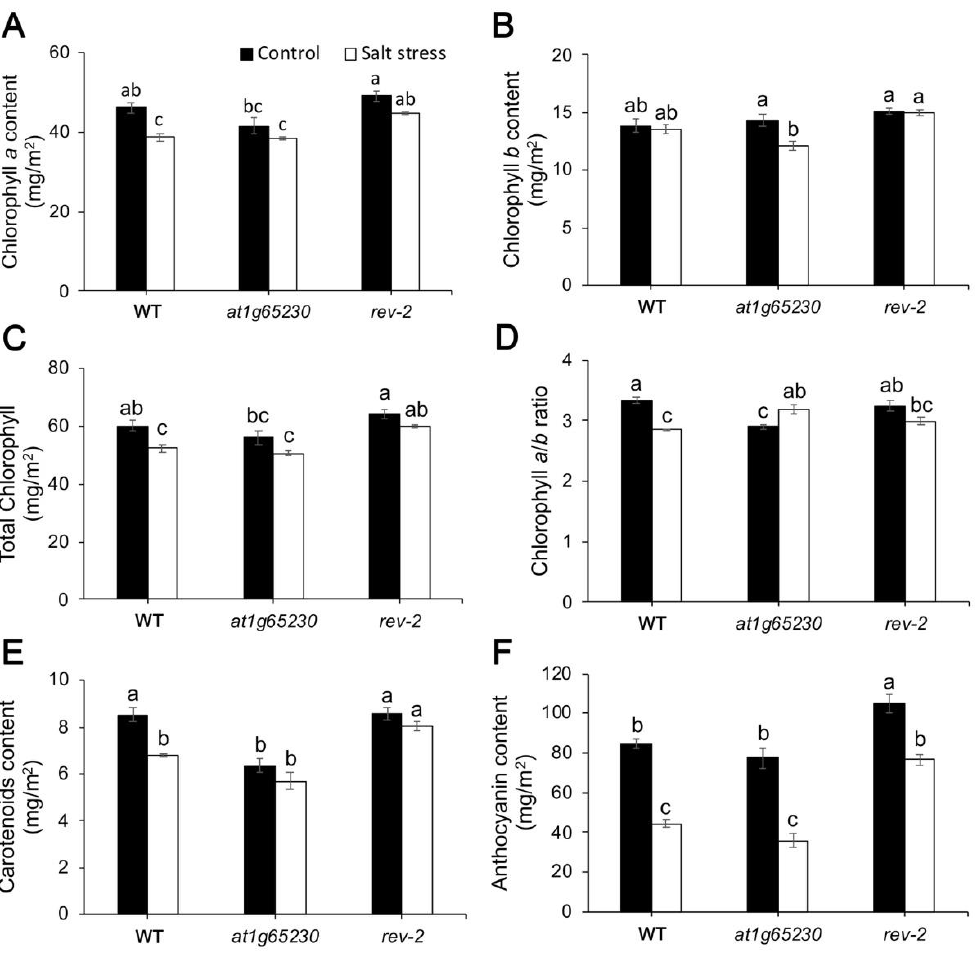
Figure 7. Pigment contents in the Arabidopsis wildtype (WT), at1g65230 mutant, and revertant line ( rev-2 ) determined after five days of culturing under control and salt-stress (200 mM NaCl) conditions: Chlorophyll a ( A ), chlorophyll b ( B ), total chlorophyll ( C ), chlorophyll a / b ratio ( D ), carotenoids ( E ), and anthocyanin ( F ). The different letters above the bars represent the significant difference among means ( p < 0.05). Error bars show SE of 4 replicates and each replicate was performed with 4 samples.